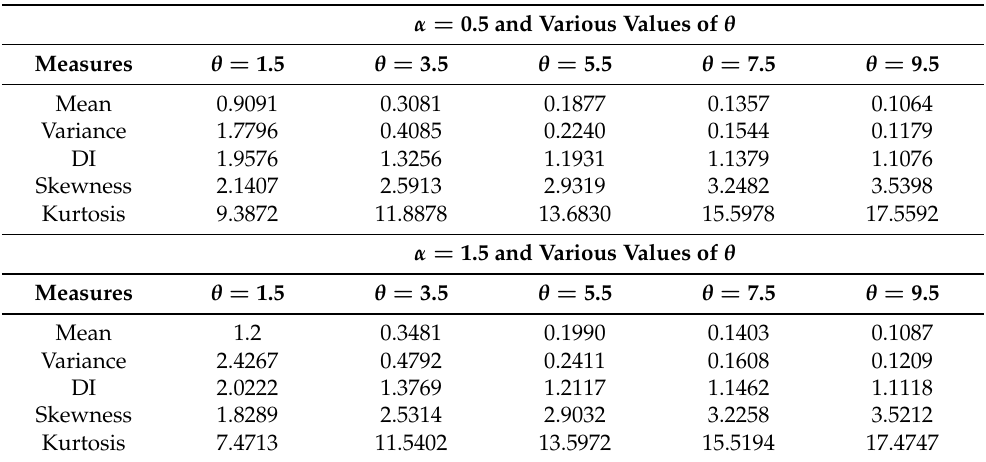
α = 1.5 and Various Values of θ Measures θ = 1.5 θ = 3.5 θ = 5.5 θ = 7.5 θ =